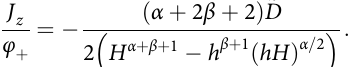
(Fig. 4a, ‘ Methods: Diffusion from a source to an active carpet sink: simulation details ’ ), which could represent particle capture by sessile suspension feeders, or substrate molecules being cata- lysed by a carpet of enzymes (also see Supplementary Movie 3).